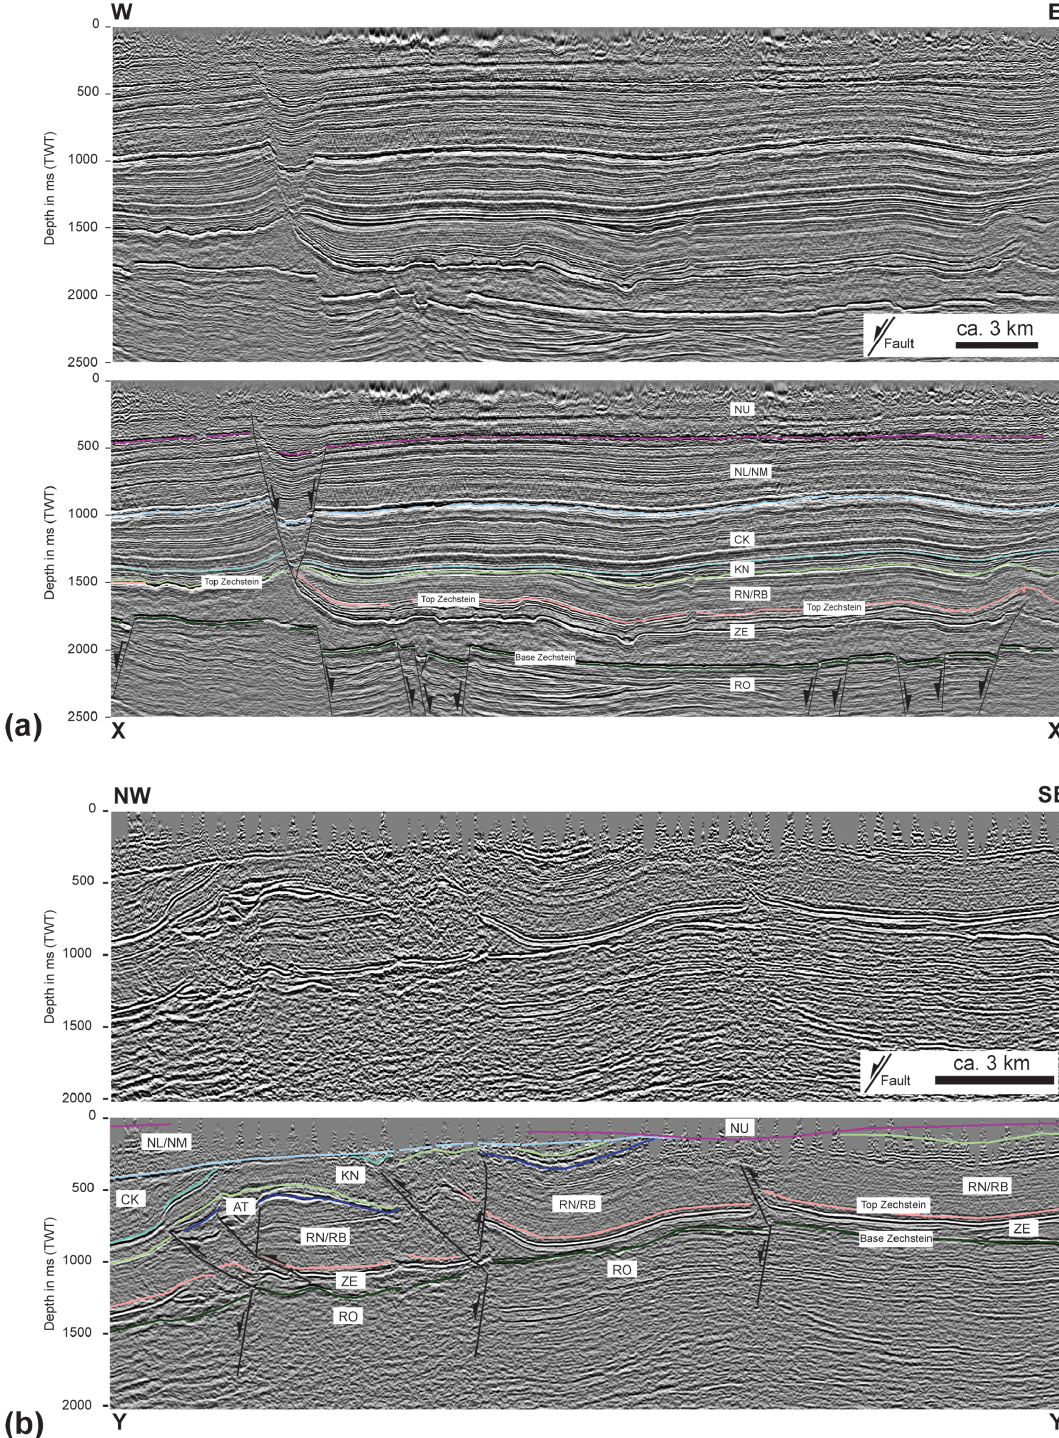
Figure 3. (a) Seismic-reflection line X – X (cid:48) across the northern–central study area. Top – uninterpreted; base – interpreted. Note Zechstein unit (ZE) and bright, strong amplitude reflection near top imaging partly deformed and folded intra-salt Zechstein 3 stringer (Strozyk et al., 2012). Incremental restoration (see, e.g., Figs. 4, 5) documents that most salt rollers, anticlines and salt walls did not grow further when buried; instead, many early salt-cored highs experienced salt loss through time. (b) Seismic-reflection line Y – Y (cid:48) across southern study area. Top – uninterpreted; base – interpreted. Note lack of upper Mesozoic and Cenozoic Zechstein overburden in the south. For line locations and stratigraphic abbreviations, see Fig.